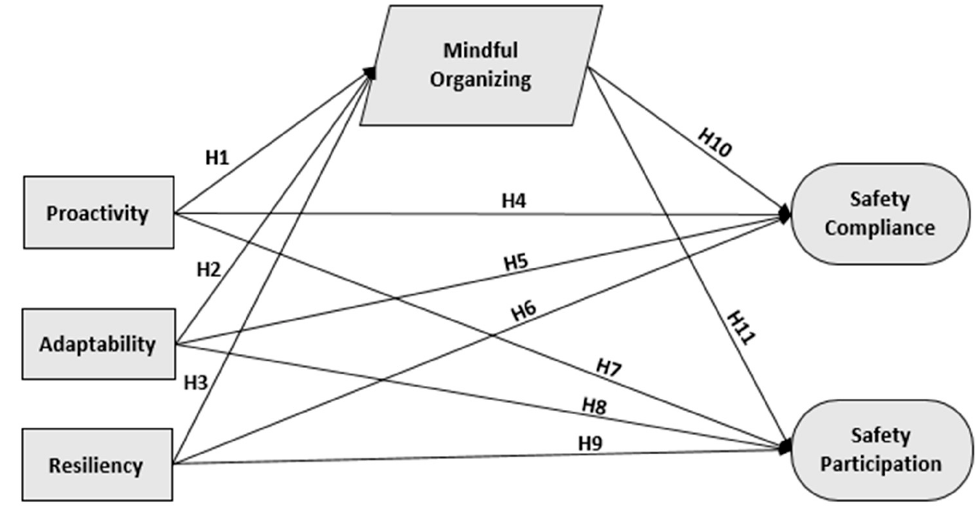
Figure 1. Proposed research framework.